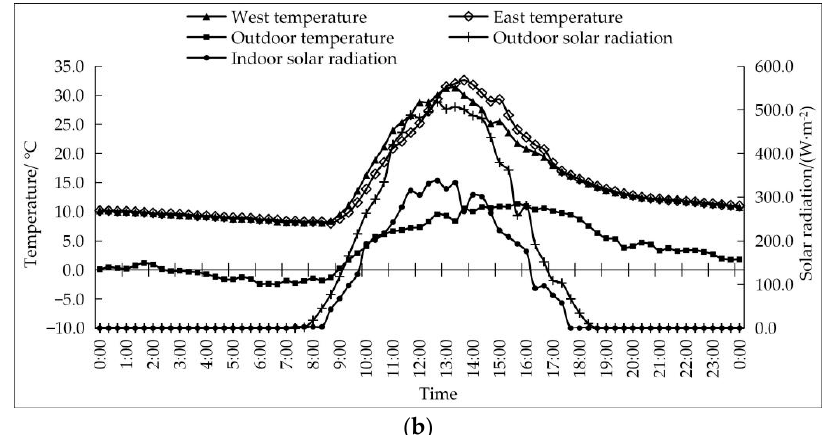
Figure 9. Typical sunny indoor and outdoor temperature, solar radiation temperature changes. ( a ) Data acquisition date is 9 February 2022; ( b ) Data acquisition date is 13 February 2022.